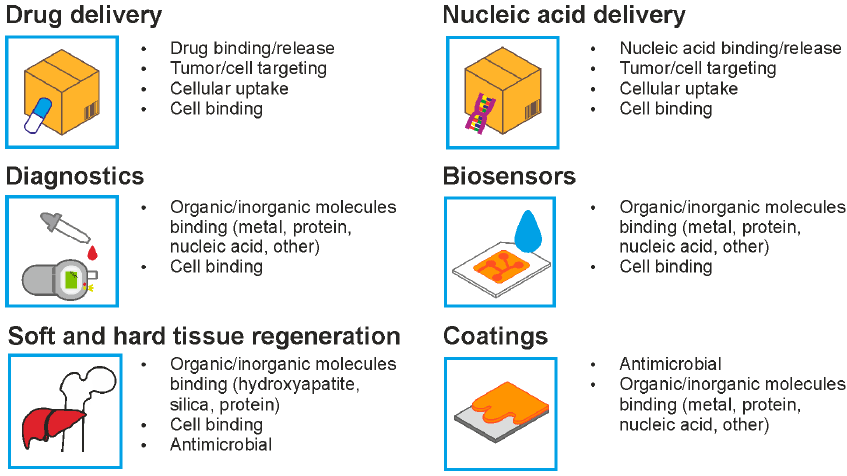
Figure 2. The functionalization of bioengineered silk towards applications.